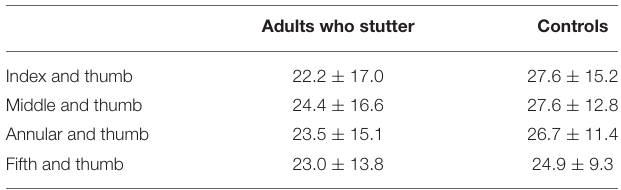
TABLE 2 | Rotation task